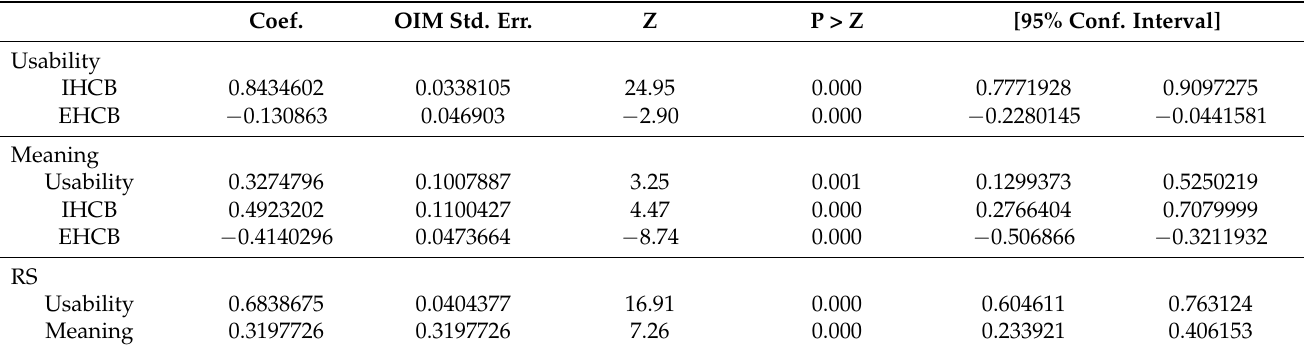
Table 5. Structural effect parameters.